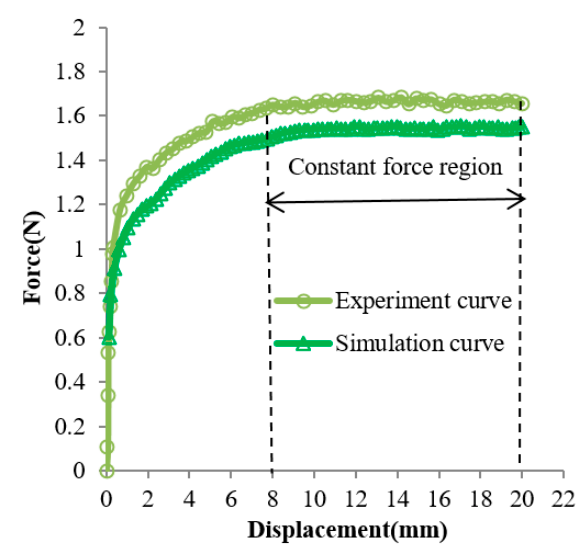
Figure 11. Comparison of optimal simulated curve ( w end = 1 mm, l 1 = 5 mm ) with its corresponding experimental curve at changing section widths.